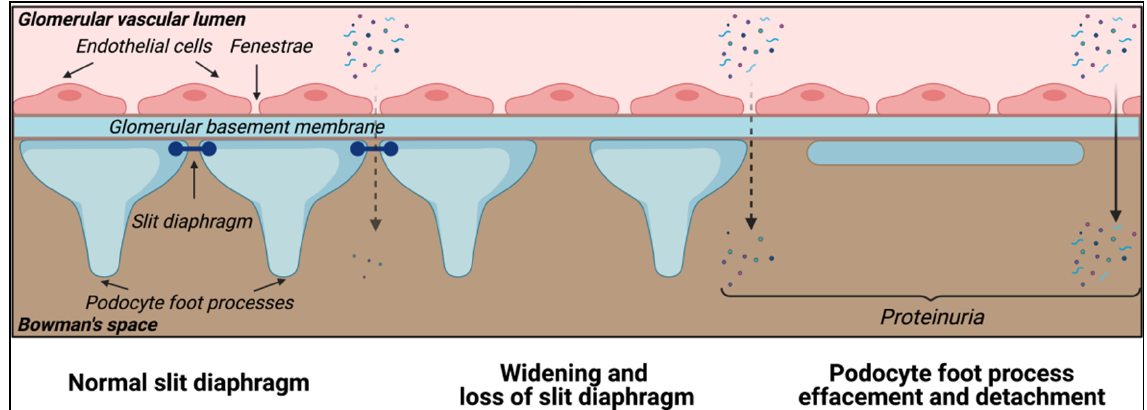
Figure 1. Podocytes: key element of the glomerular filtration barrier. Podocytes are highly differentiated cells with a specific cellular architecture, comprising primary and secondary foot processes that wrap around the glomerular capillaries, and express essential proteins that define the slit diaphragm and permselectivity of the glomerular filtration barrier. Kidney diseases affecting the podocytes (podocytopathies) can be characterized by the loss of the slit diaphragm, podocyte foot process effacement and detachment, which clinically manifests as glomerular proteinuria.